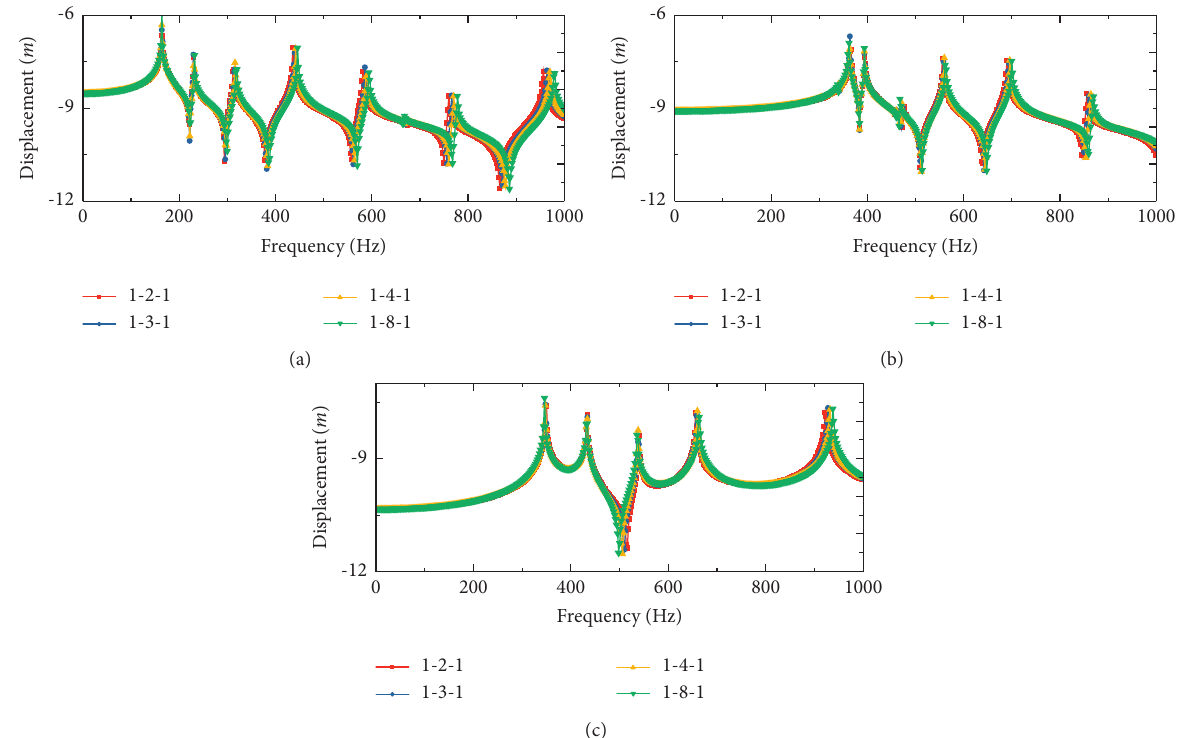
Figure 14: Study on the effect of thickness on the steady-state response of Sandwich FGP doubly curved structure: (a) Sandwich pa- raboloidal honeycomb shell; (b) Sandwich hyperbolic honeycomb shell; (c) Sandwich elliptical honeycomb shell.